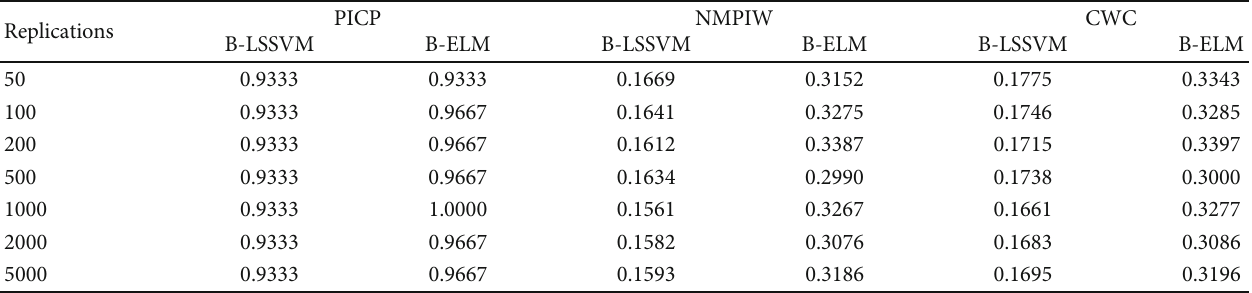
Table 4: PI performance index of ZG290.